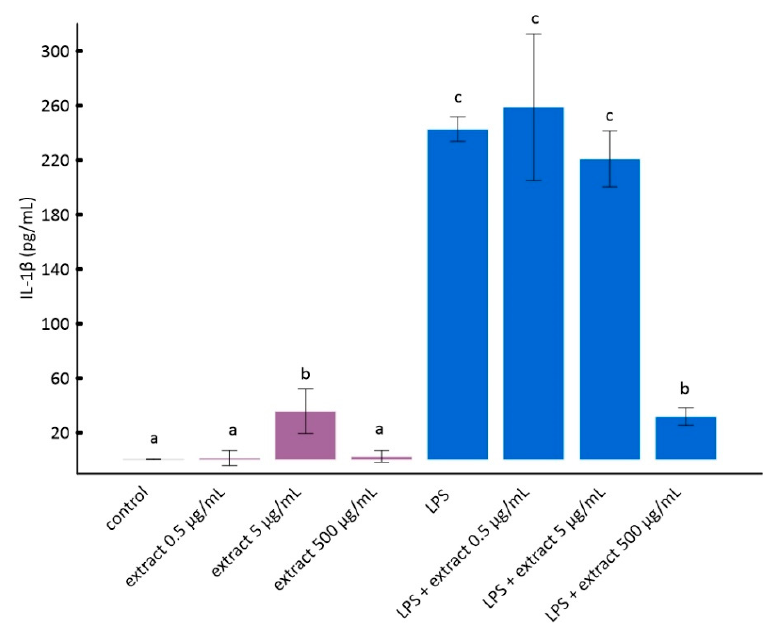
Figure 2. The influence of aronia extract on lipopolysaccharide-induced production of interleukin 1 β . The values are means ±SD. The same letter (a, b, and c) indicates that there is no statistically significant difference between the analyzed samples at a confidence level of p < 0.05. The different letter indicates the significant difference ( p < 0.05) among the mean values. The results are ordered as follows: a < b < c.